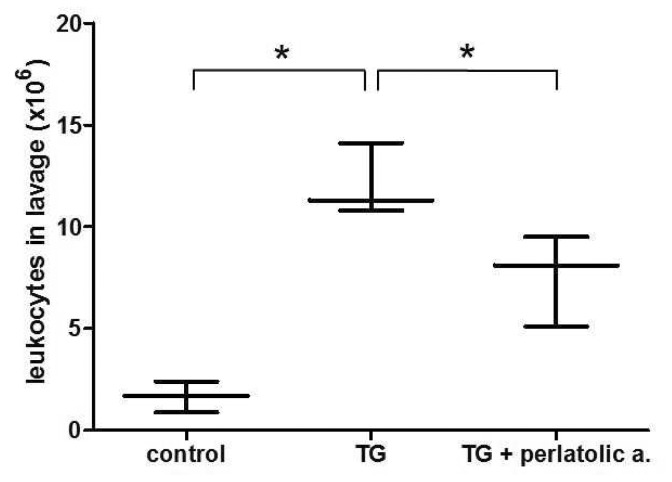
Perlatolic acid (5) inhibits leukocyte recruitment in thioglycollate-induced peritonitis mouse model.Box and whisker plots represent median, lowest and highest detected values (n=3; **p<0.001, *p<0.05; ANOVA/Tukey).